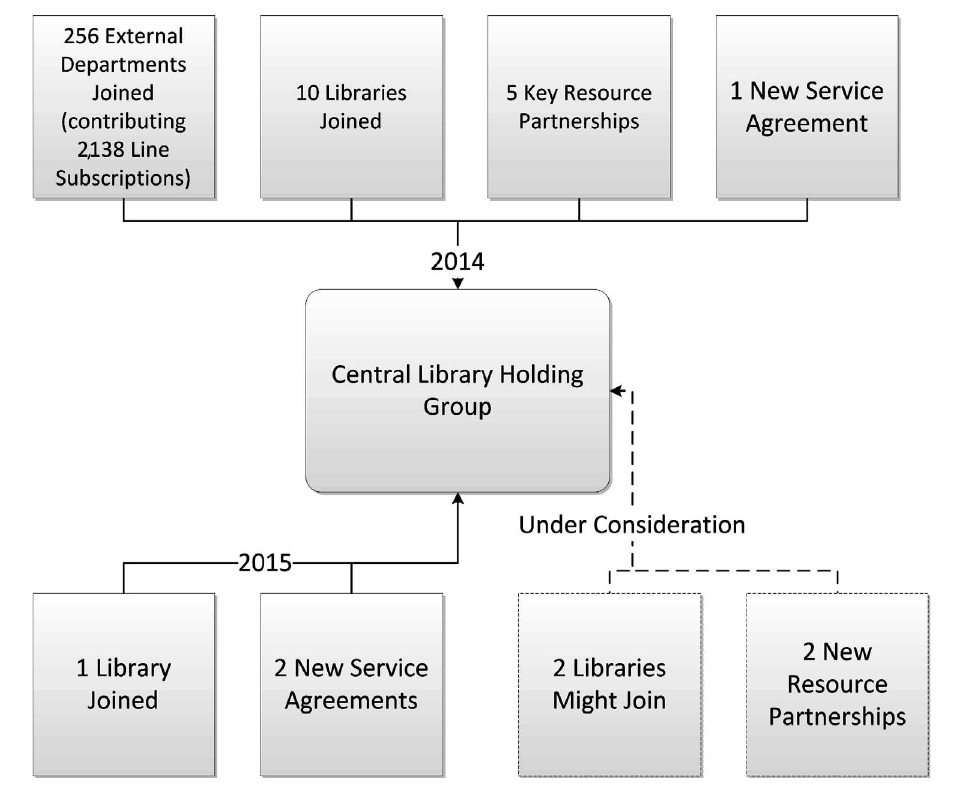
How the library group is